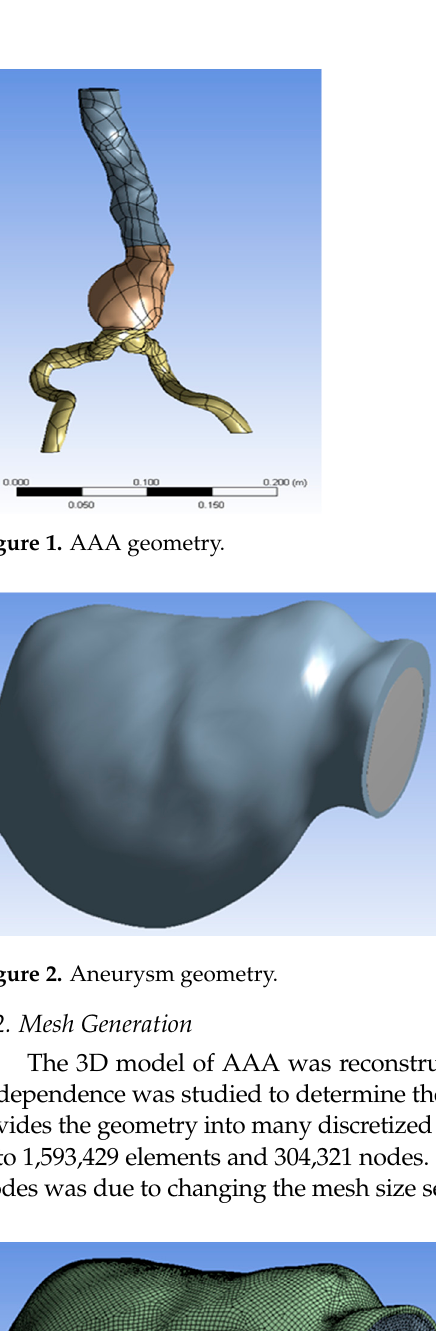
Figure 2. Aneurysm geometry.